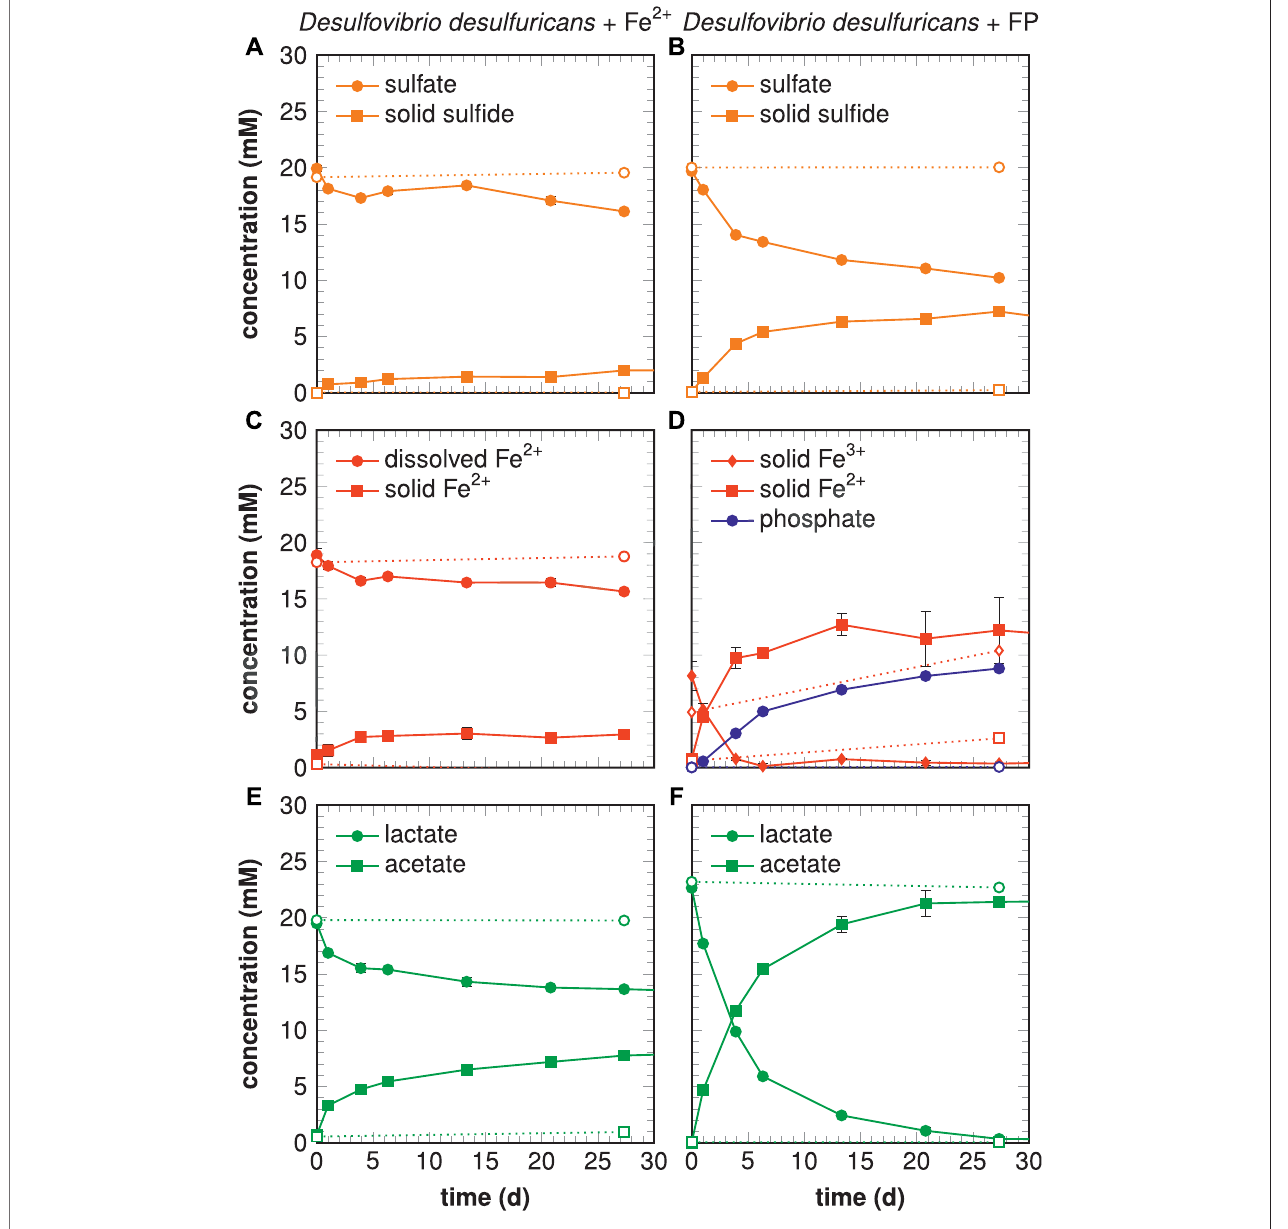
FIGURE 1 | Chemical compound concentrations in biotic ( fi lled solid) and abiotic (open dotted) experiments for dissolved Fe 2 + (left panels) and Fe III -phosphate (rightpanels)conditions. (A , B) Sulfurcompounds:dissolvedsulfate(circle)andsolidsul fi de(square). (C , D) Ironandphosphatecompounds:dissolvedFe 2 + (circle),solid ferrousiron(square),solidferriciron(diamond),anddissolvedphosphate(circle). (E , F) Organicacidcompounds:dissolvedlactate(circle)anddissolvedacetate(square).